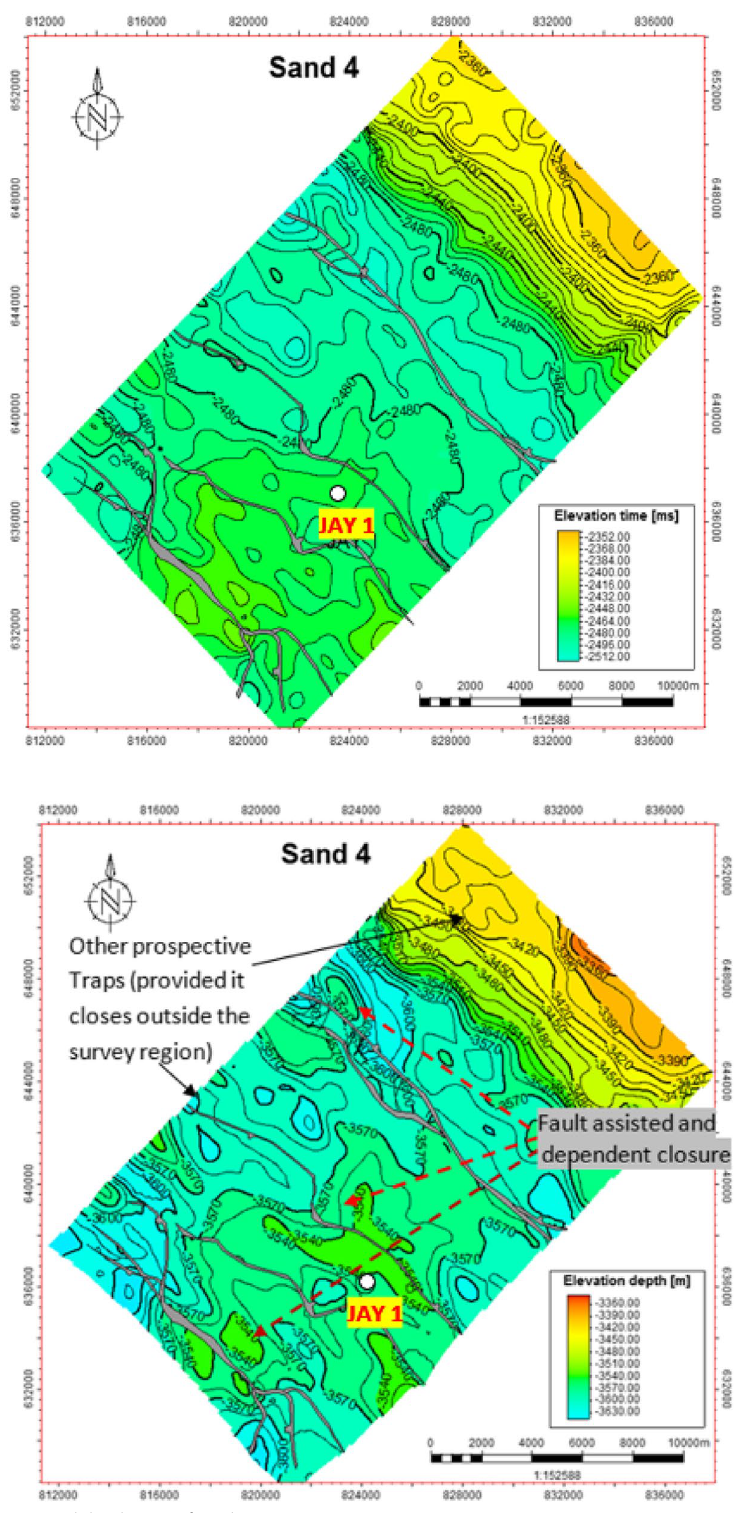
Fig. 16 Time and depth map of sand